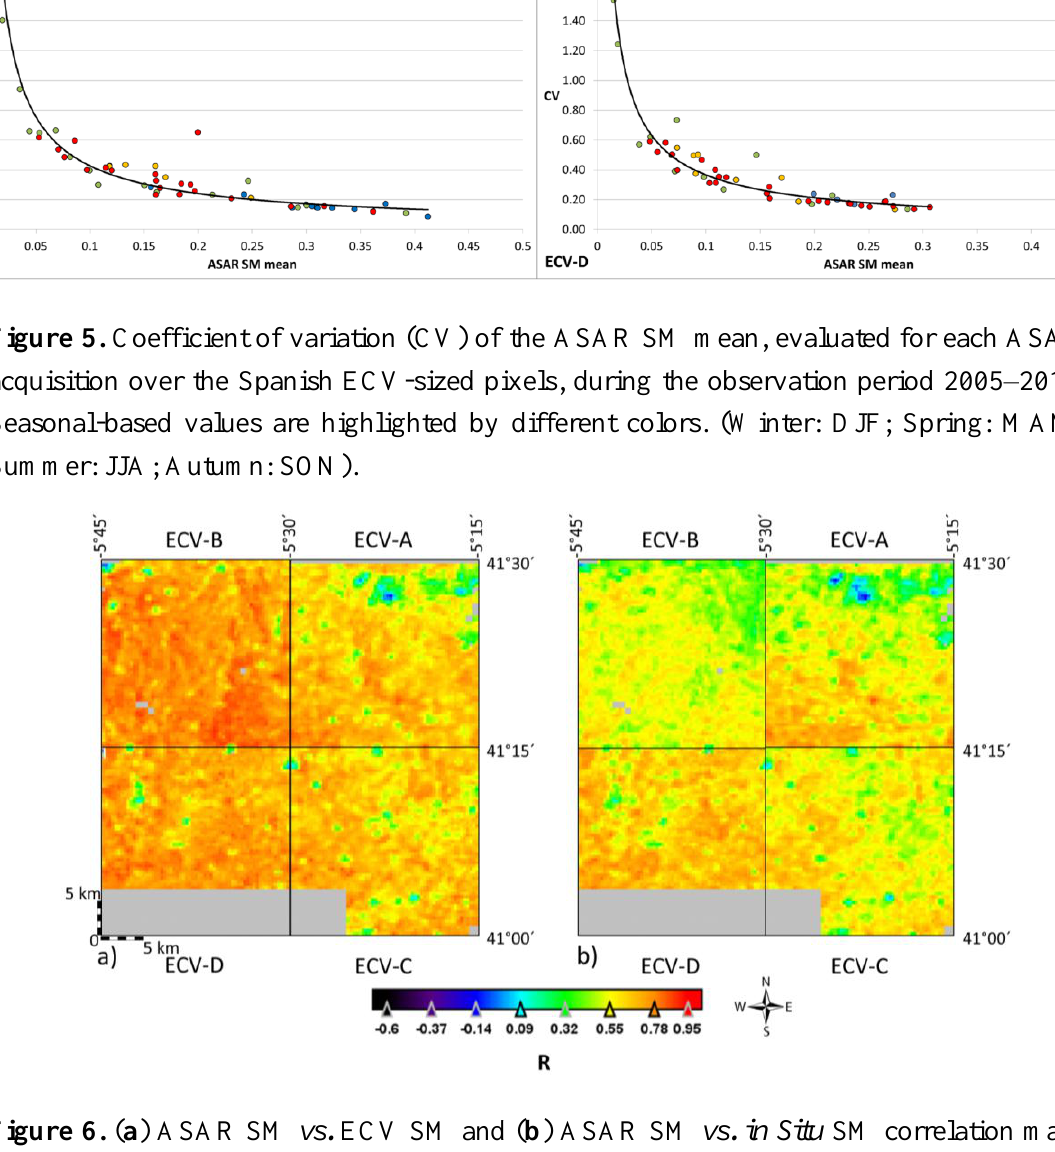
Figure 6. ( a ) ASAR SM vs. ECV SM and ( b ) ASAR SM vs. in Situ SM correlation maps evaluated for each ASAR WS pixel (1 km × 1 km after resampling). The soil moisture ground measurements in ECV-B and ECV-D are provided by a single instrument installed in each of the ECV cell areas. For the analysis in ECV-A and ECV-C, where multiple soil moisture stations are located, the daily mean values of soil moisture recorded by each instrument within a single ECV cell has been